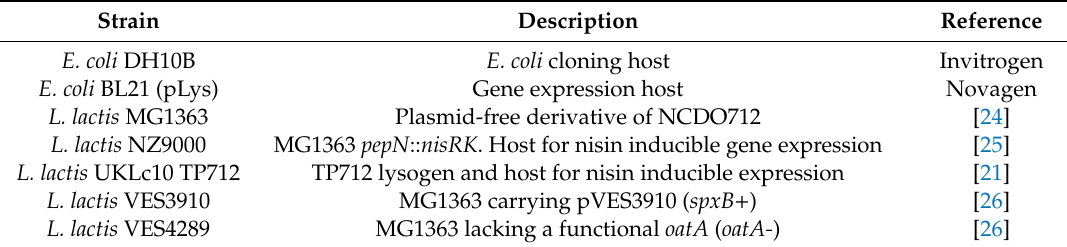
Table 1. Bacterial strains used in this work.